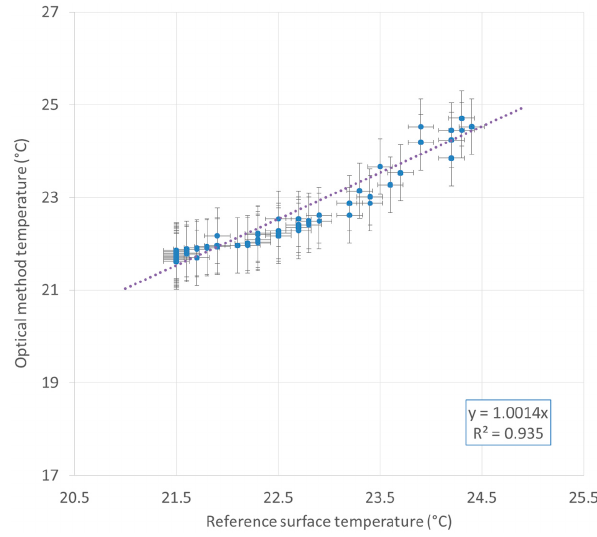
Figure 13. Optical method temperature versus reference surface temperature and linear regression.